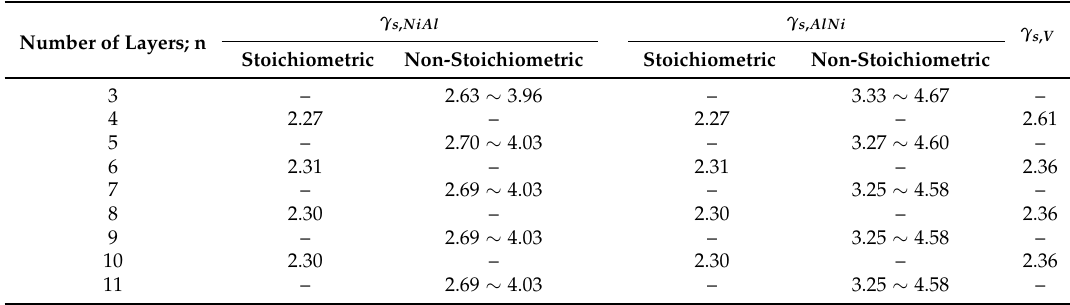
Table 4. Convergence of the surface energy γ s (J/m 2 ) of NiAl (Al-terminated), AlNi (Ni-terminated) and V with respect to the number of atom